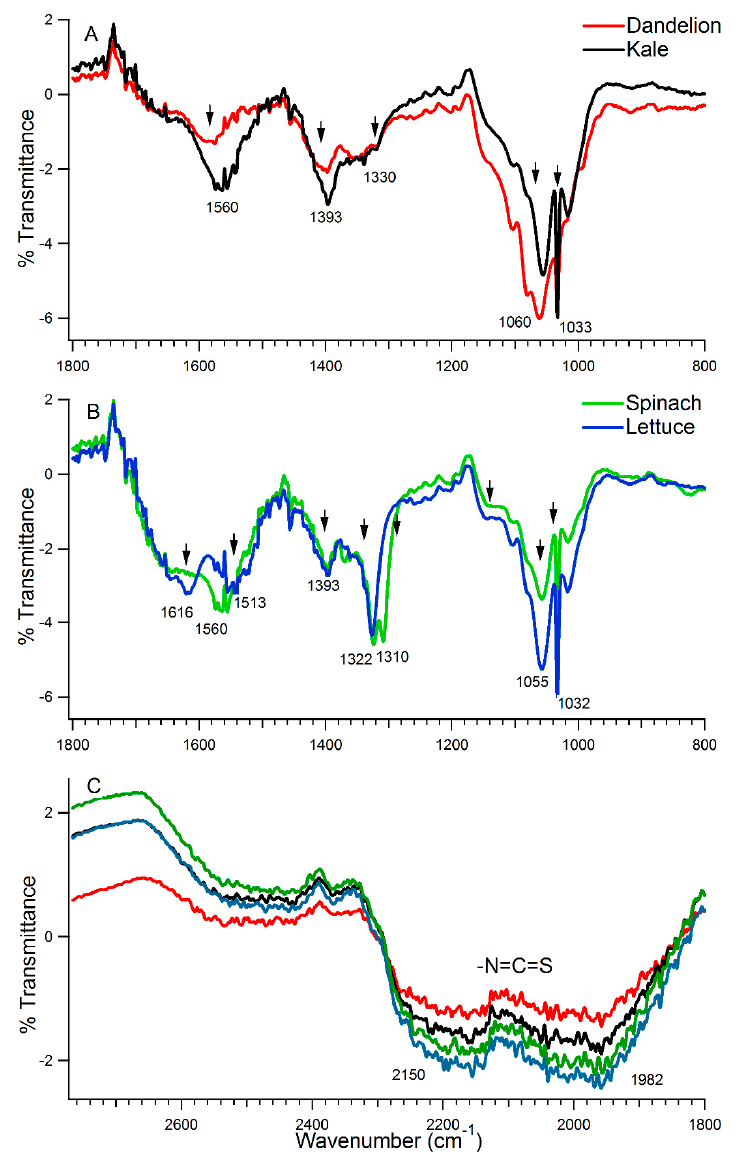
Figure 8. Attenuated Total Reflection–Fourier Transform Infra-Red (ATR-FTIR) spectra (water subtracted) of aqueous extracts of leaves of ( A ): kale (black), dandelion (red); ( B ): spinach (green) and lettuce (blue) in the region 800–1800 cm − 1 ; and ( C ): The fingerprint area of isothiocyanates (in the region 1800–2800 cm − 1 ) for all the extracts. The full scans of the raw extracts are provided in Figure S3. Table 2. Peaks with significant intensities in the Attenuated Total Reflection–Fourier Transform Infra-Red (ATR-FTIR) spectra of the vegetable juices (kale, dandelion, spinach, and lettuce). Possible Vibrations Vibrational Frequencies of Vegetable Juice (cm − 1 ) Kale Dandelion Spinach Lettuce Aromatic -C=C stretching -OH stretching symmetrical and asymmetrical stretching vibration B b B for the carboxyl ion (COO–) indicating the existence of carboxylic acid, ester, or carbonyl groups Part of isothiocyanate signature, 1560 s deformations and stretching of aromatic C=C